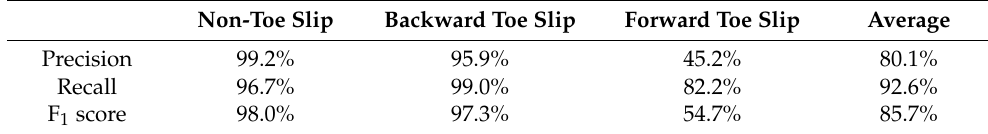
Figure 12. LOSOCV for toe slip classifier. NTS represents non-toe slips, BTS represents backward toe slips, and FTS represents forward toe slips. Table 5. Toe slip classifier performance.